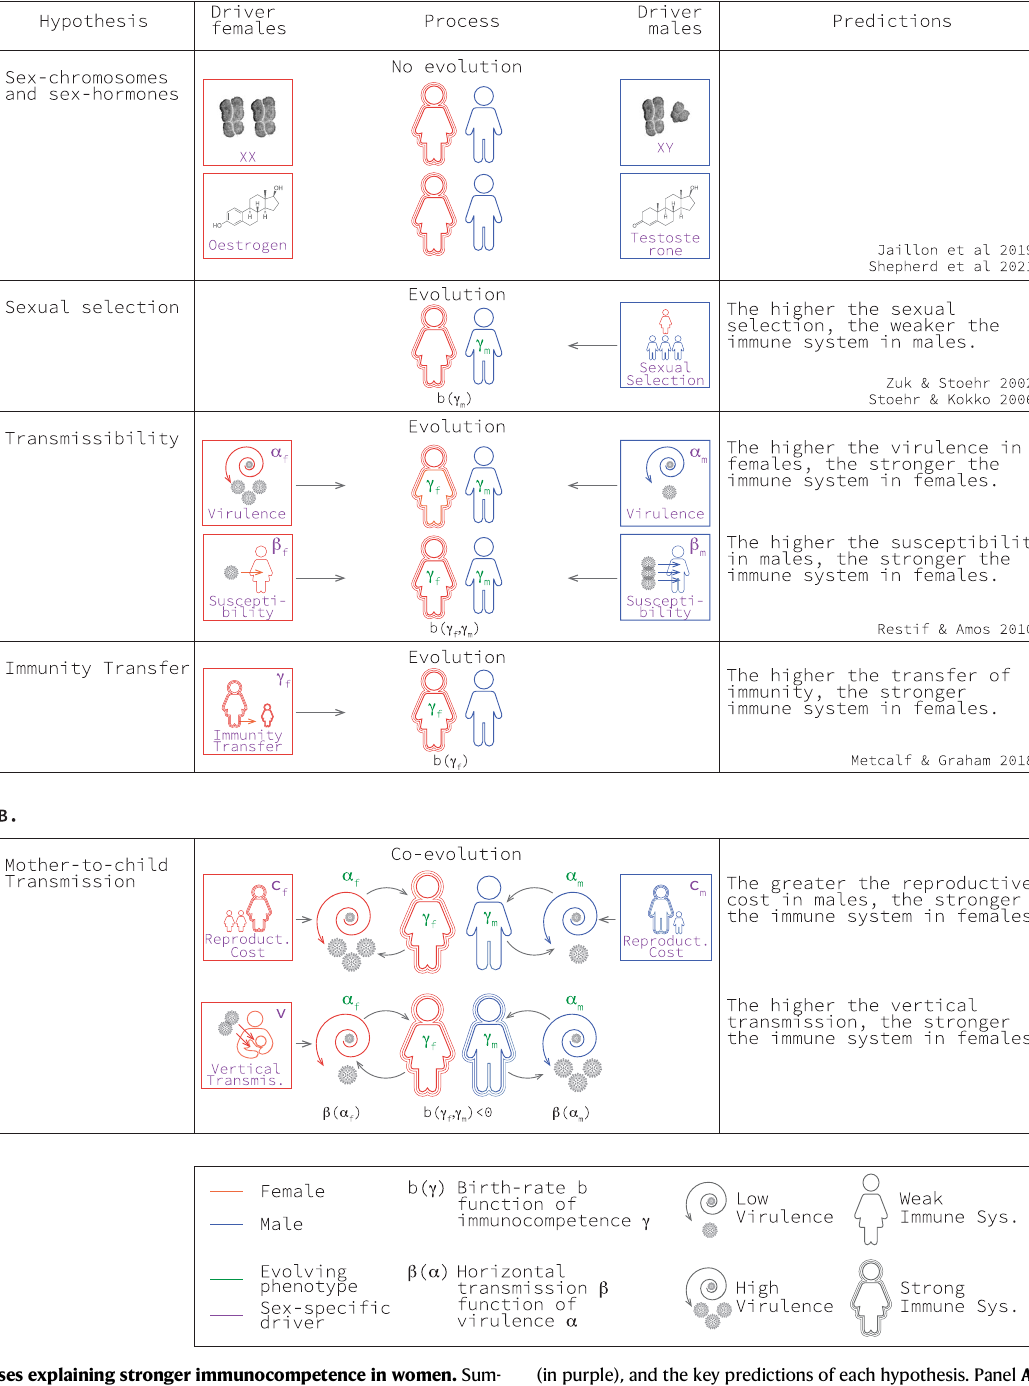
(in purple), and the key predictions of each hypothesis. Panel A corresponds to previous work, while panel B corresponds to the work presented